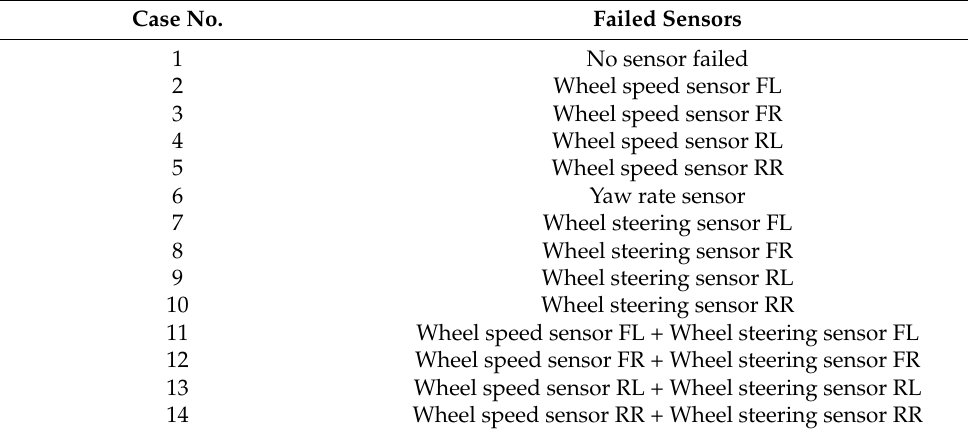
Table 3. Cases to analyze the robustness of odometry. Case No. Case